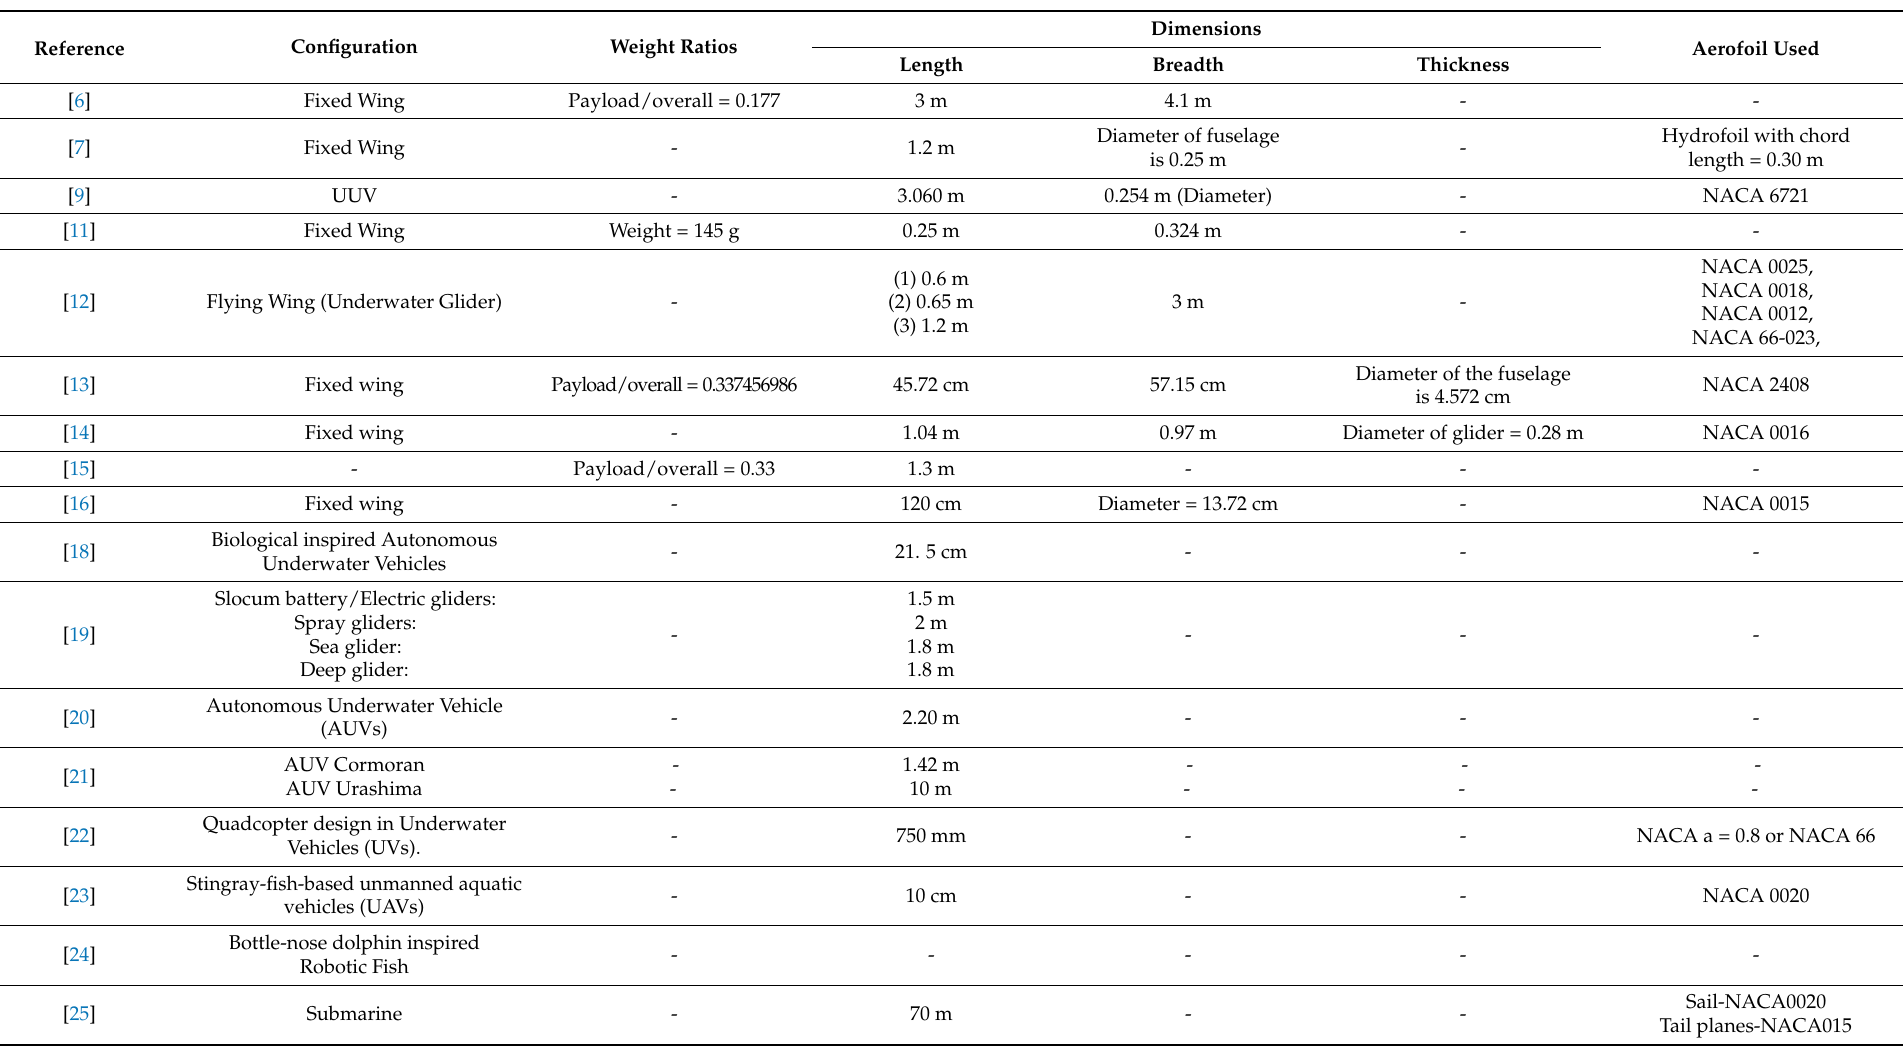
Table 1. Comparative information about design of unmanned underwater